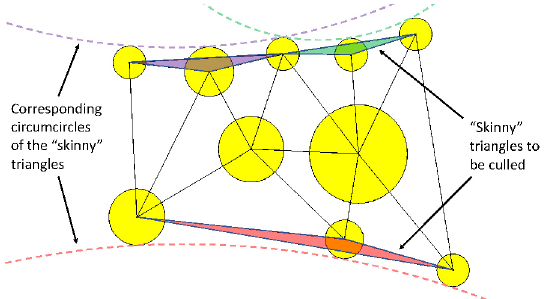
Fig. 18 Boundary-artifact triangles and their corresponding circumcircles.